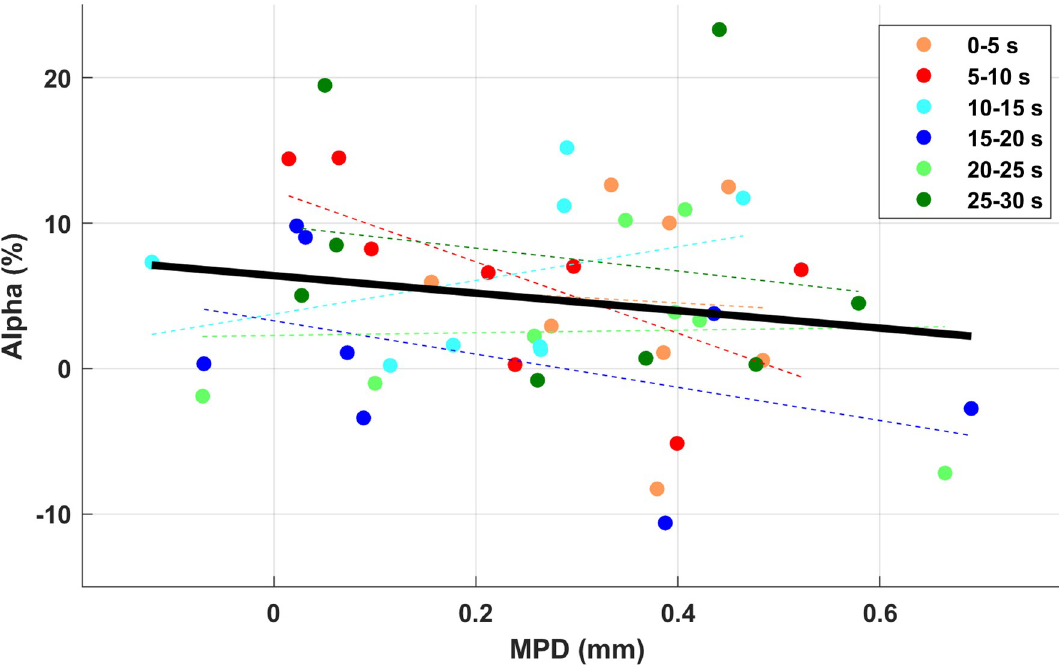
Fig 3. The partial correlation between the difference of MPD and alpha power, with time as the covariance. No significant correlation was found.